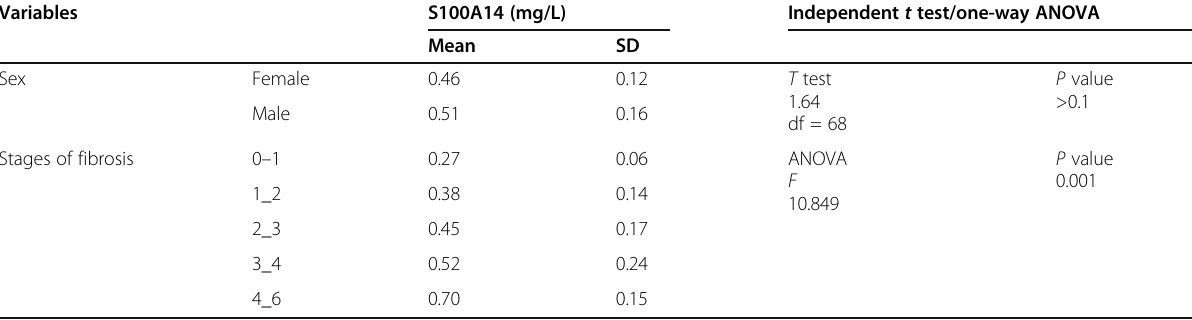
Table 4 The relation between S100A14 as regards sex and stages of fibrosis